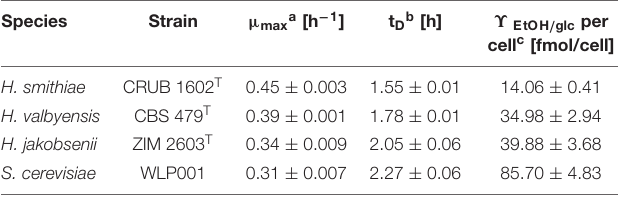
TABLE 1 | Growth characteristics of H. smithiae, H. valbyensis, H. jakobsenii , and S. cerevisiae . Species Strain